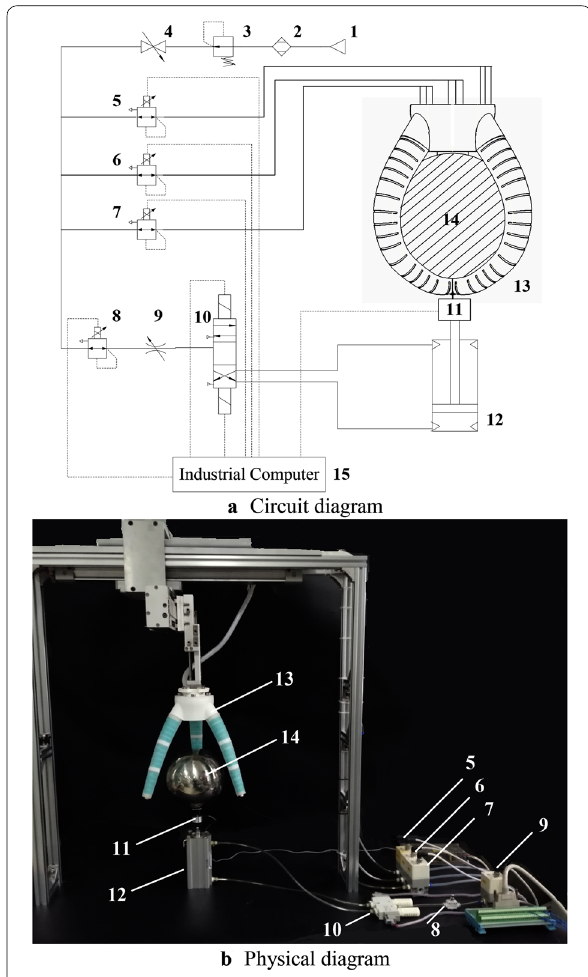
Figure 13 Gripping force testing circuit. 1. Air source; 2. Dryer; 3. Reducing valve; 4. Shut-off valve; 5, 6, 7, 8. Proportional pressure valve; 9. Throttle valve; 10. Solenoid directional valve; 11. Tension sensor; 12. Cylinder; 13. E-Gripper; 14. Sphere; 15. Computer